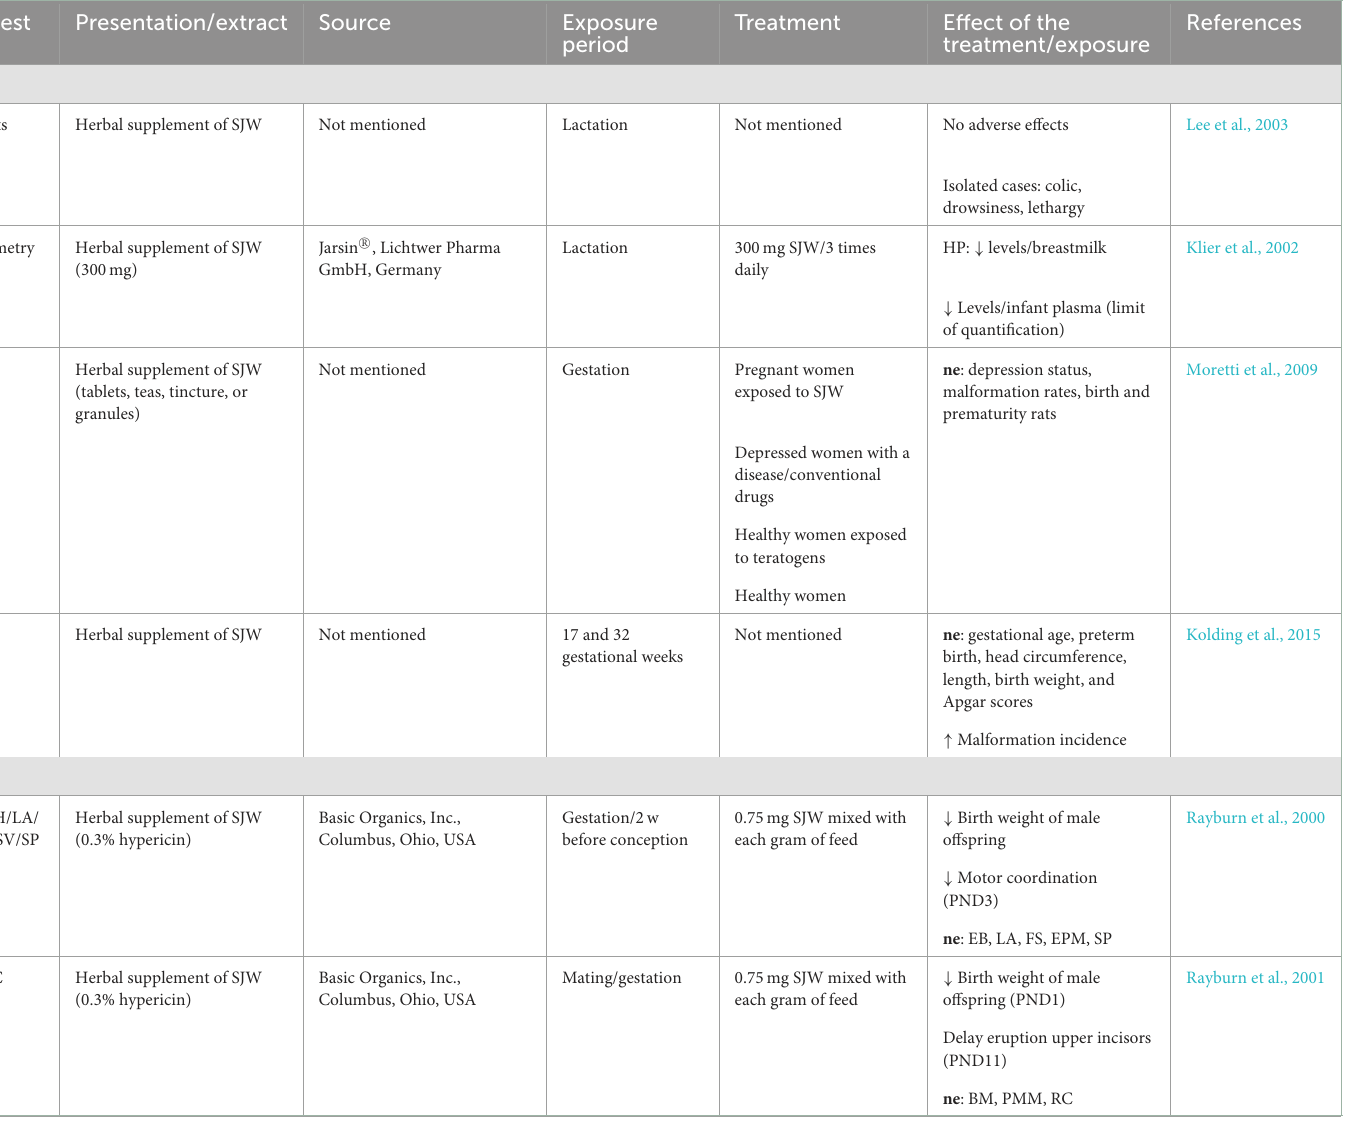
TABLE 1 Effects of the exposure to SJW and/or its bioactive compounds during the prenatal and postnatal periods in the